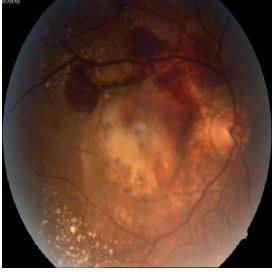
Macular Edema in Retinal vein occlusion